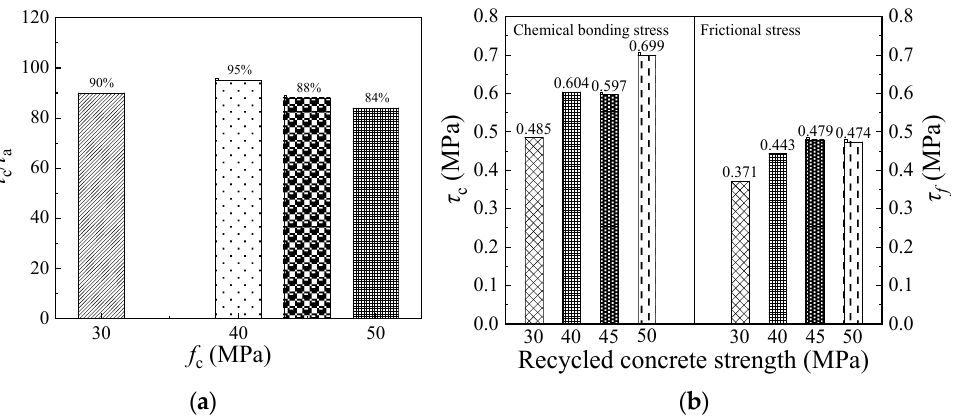
Figure 16. The effect of recycled concrete strength on the bonding capacity. ( a ) The effect of recycled concrete strength on l c / l a ; ( b ) the effect of recycled concrete strength on chemical bonding stress and friction resistance stress.